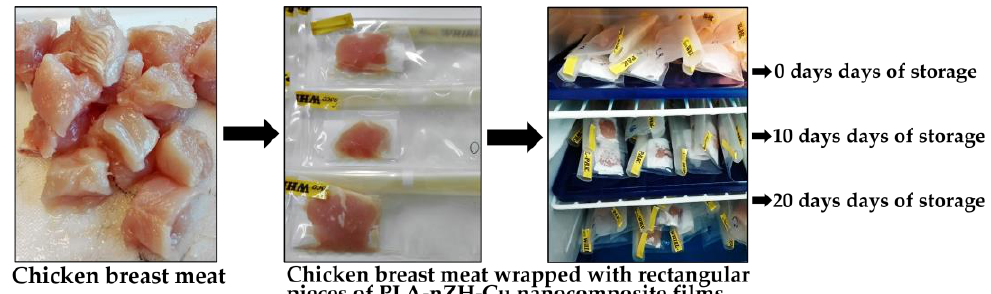
Figure 3. Chicken meat pieces wrapped in PLA-nZH-Cu nanocomposite films placed inside sterile bags and stored at 4 °C. The samples were analyzed at 0, 10, and 20 days of